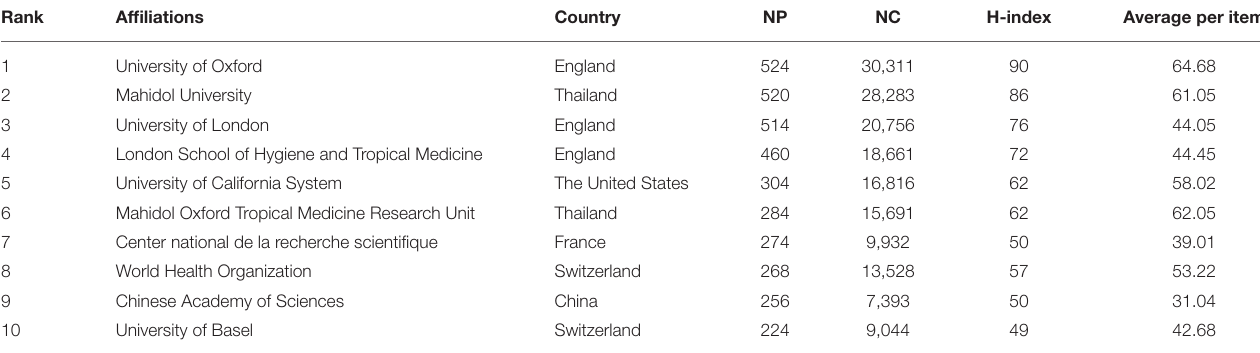
TABLE 2 | The top 10 productive